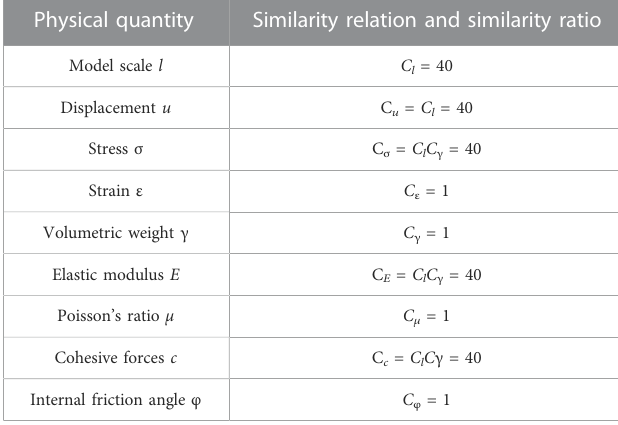
TABLE 2 Model similarity relation and similarity